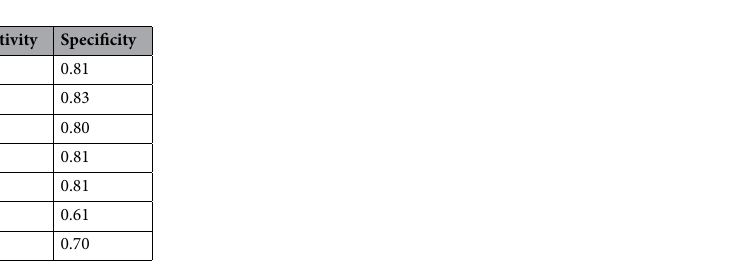
Figure 3. Relative feature importance computed using the Boruta algorithm. The blue violin plots correspond to the minimal, average, and maximum Z scores of a shadow attribute. The red and green violin plots represent the Z scores of the rejected and confirmed attributes, respectively. The black dots and horizontal lines within each violin plot represent the mean and median values, respectively. All features that received a lower relative feature importance than that of the shadow feature were defined as irrelevant for prediction. Laterality was considered as an irrelevant feature (marked in red).